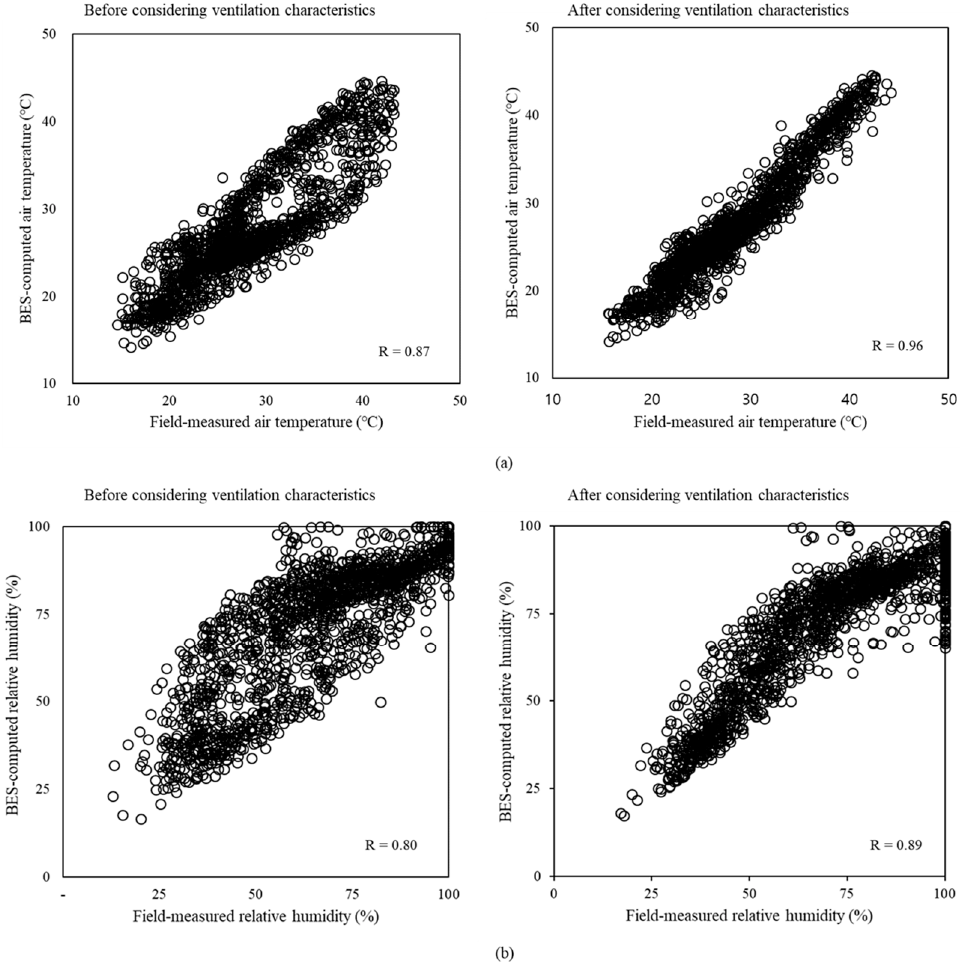
Figure 15. Comparison between BES-computed result of the greenhouse model and field-measured data considering ventilation characteristics of the greenhouse ( a ) air temperature and ( b ) relative humidity.